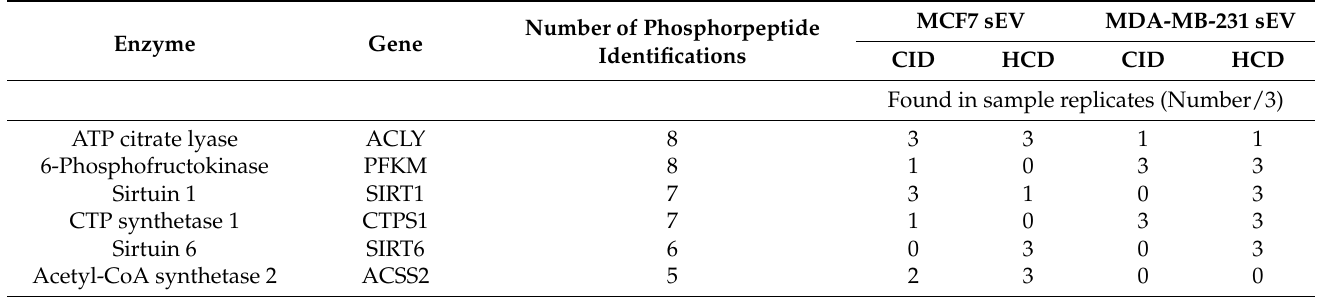
Figure 5. KEGG pathway analysis of phosphoproteins derived from MCF10A, MCF7, and MDA-MB- 231 sEVs. Table 1. Summary of the identifications of phosphosites for enzymes in three biological replicates of MCF7 and MDA-MB-231 sEVs. Six proteins were identified using IMAC and either CID or HCD fragmentation method in all three replicate samples in at least one cell line. In addition, PKFM has also been identified from TiO 2 enrichment in two replicates using HCD fragmentation in contrast with the